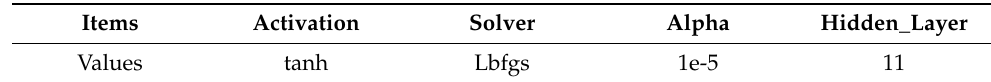
Table 11. The parameters of MLP.